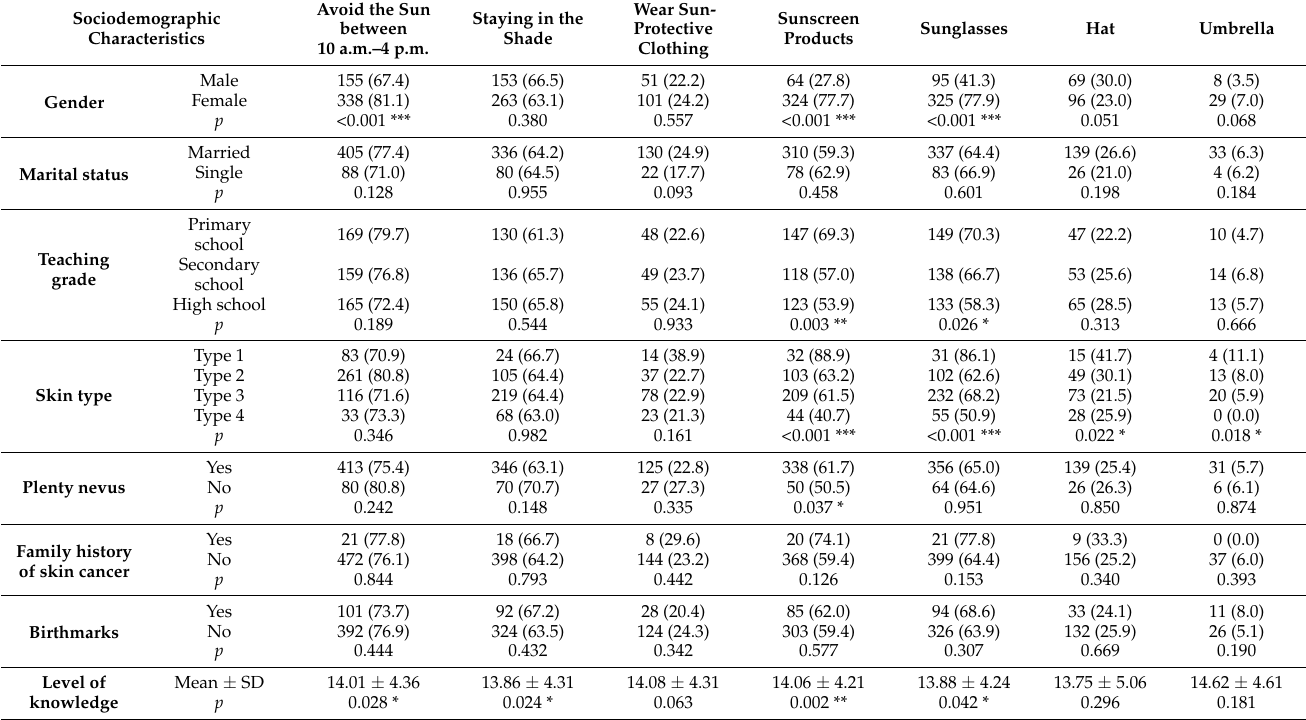
Table 3. Status of sociodemographic characteristics according to sun-protection methods.